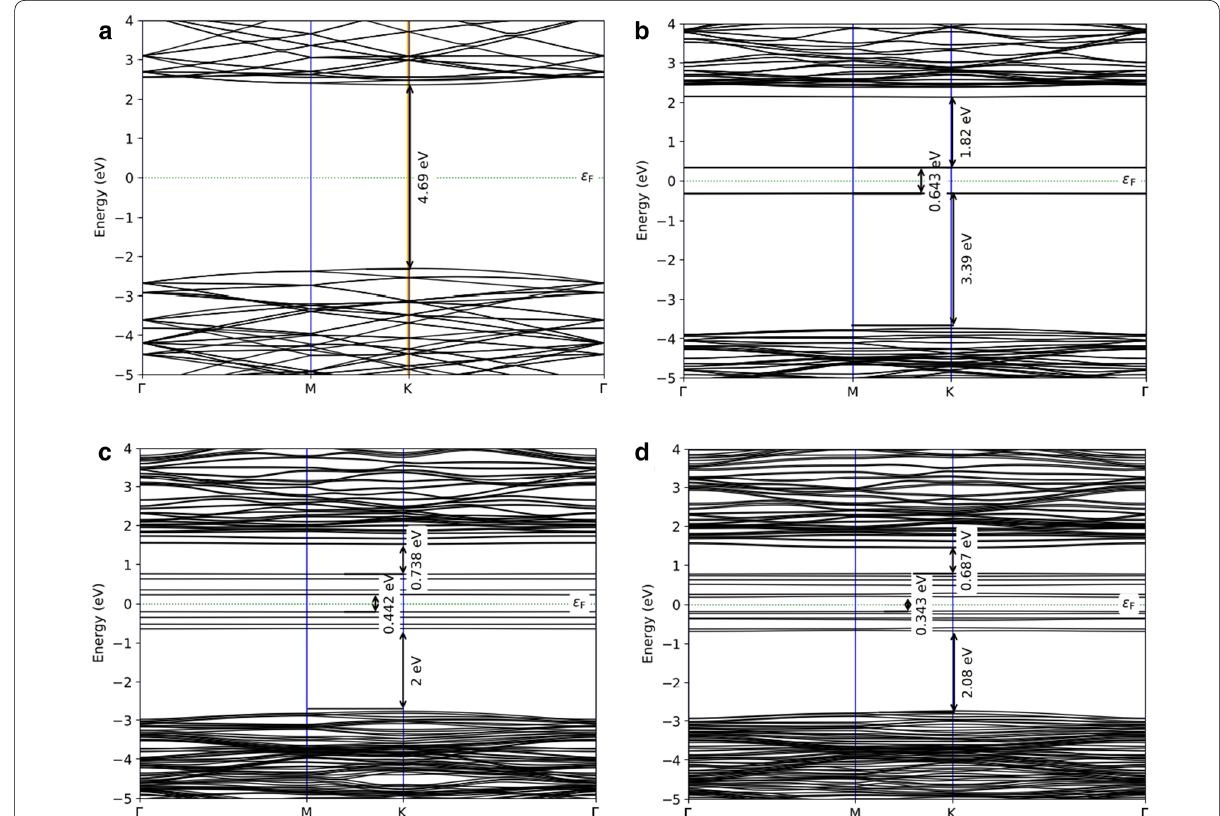
Fig. 4 The computed electronic band structure of a pristine BN and Bi‑doped monolayers with concentrations b 2.04%, c 4.08%, and d